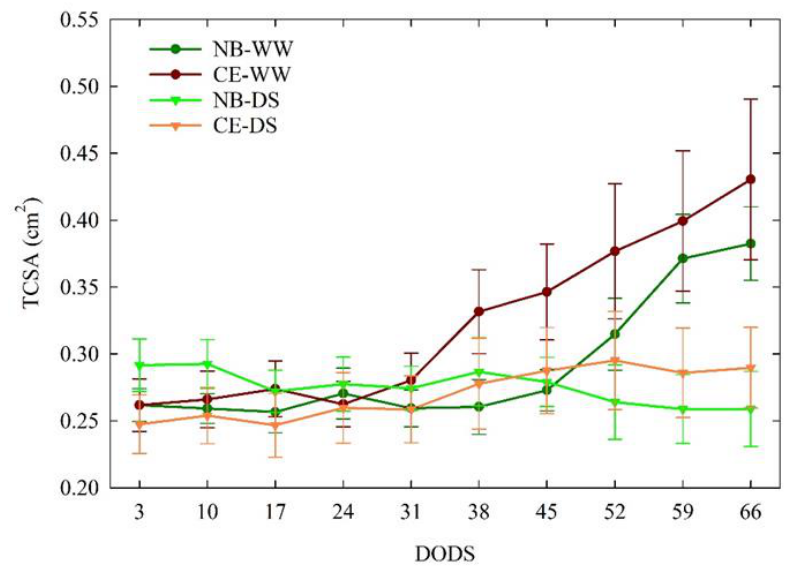
Figure 5. Trends of trunk cross-sectional area (TCSA) in well-watered and drought-stressed ‘Nocellara del Belice’ (NB-WW and NB-DS, respectively) and ‘Cerasuola’ (CE-WW and CE-DS, respectively) olive trees. Error bars indicate the standard errors of the means.